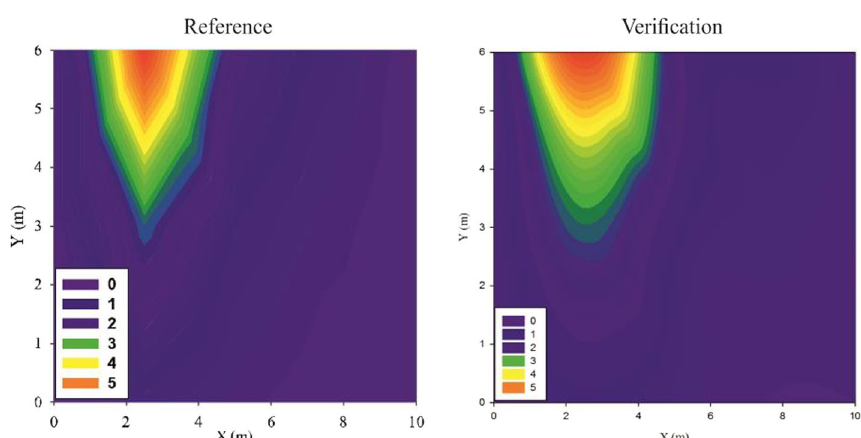
Fig. 4 Comparison of damage severity and extent detected by the performed modeling with the reference